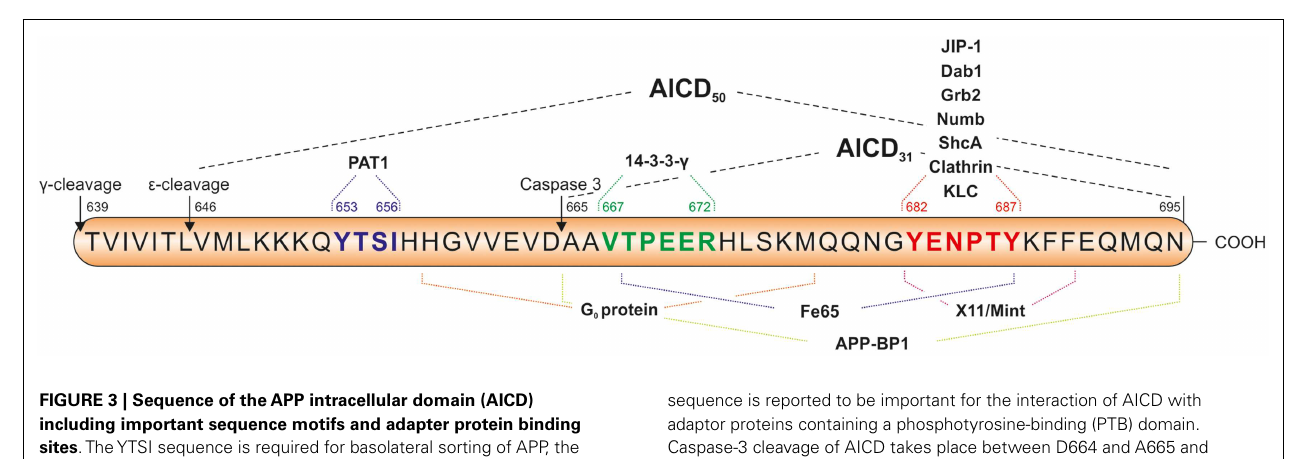
FIGURE 3 | Sequence of theAPP intracellular domain (AICD) including important sequence motifs and adapter protein binding sites .TheYTSI sequence is required for basolateral sorting of APP, the VTPEER site is involved in pathophysiology and includes theThr668 residue, which is the major phosphorylation site of APP.The GYENPTY